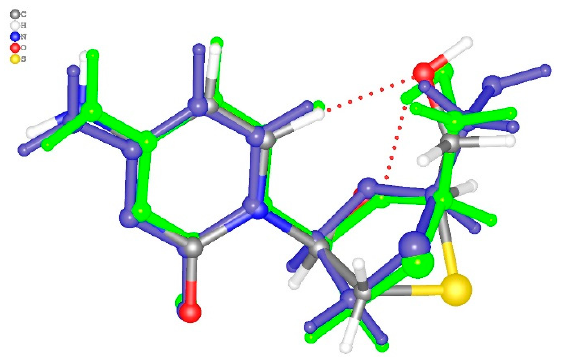
Figure 3. The superimposed structures of 3TC in crystal, complex A (blue color) and complex B (green color). Intermolecular C-H…O and O-H…O bonds are shown by the red dotted lines.